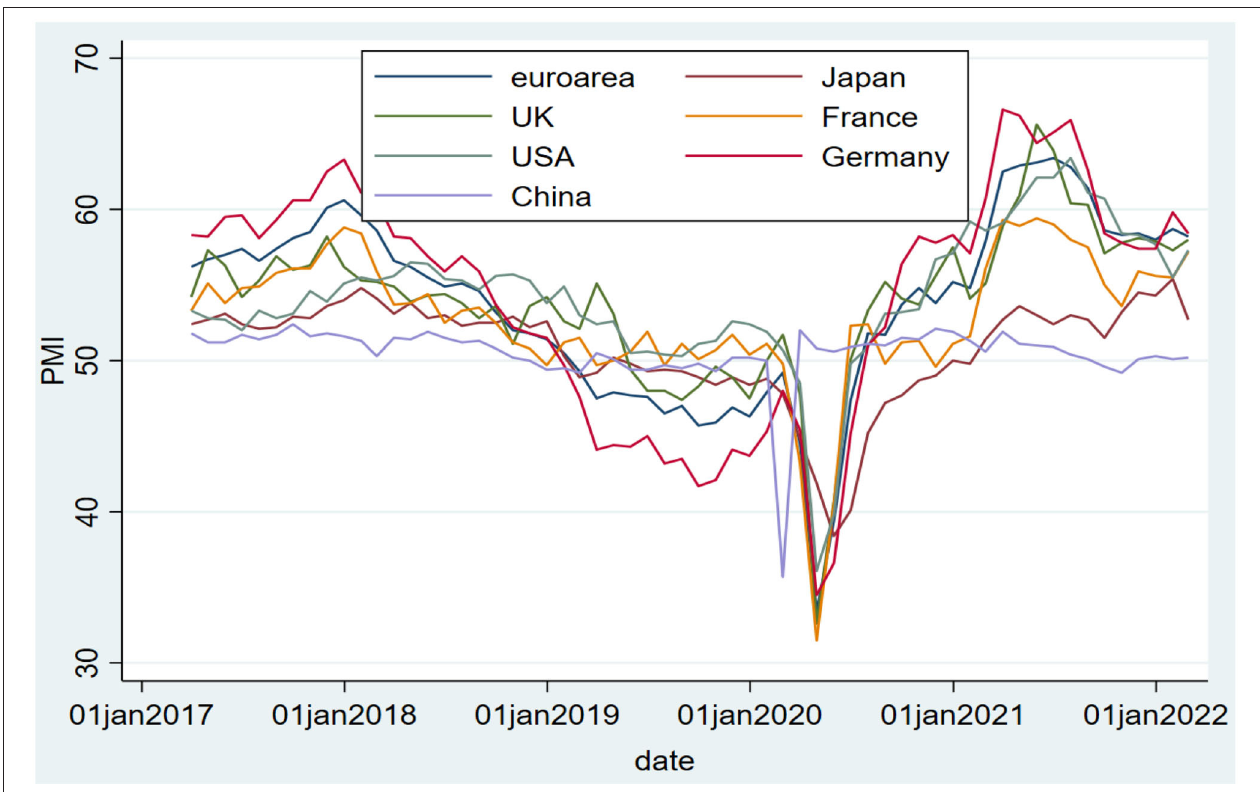
FIGURE 2 | Manufacturing PMI values for several